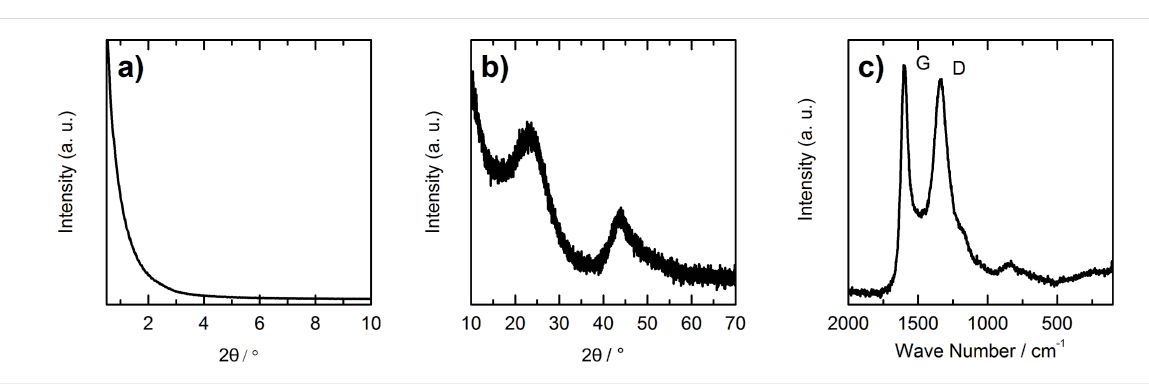
Figure 3: a) Small-angle and b) wide-angle XRD patterns as well as c) Raman spectrum of hollow carbon